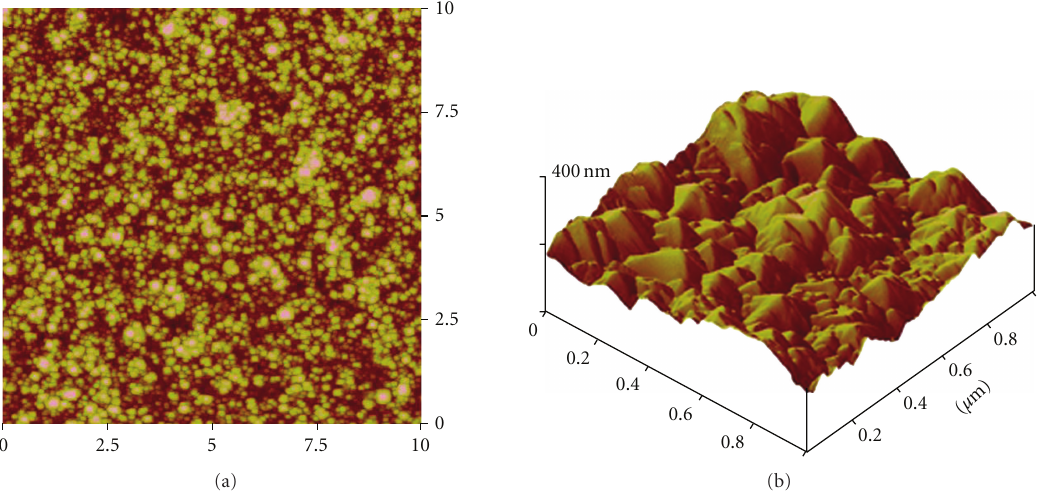
Figure 3: AFM images of diamond membrane, (a) 1 × 1 μ m and (b) 10 × 10 μ m. The diameter of diamond grain is around 50 to 100 nm, and the root mean square (RMS) roughness is around 26 nm.